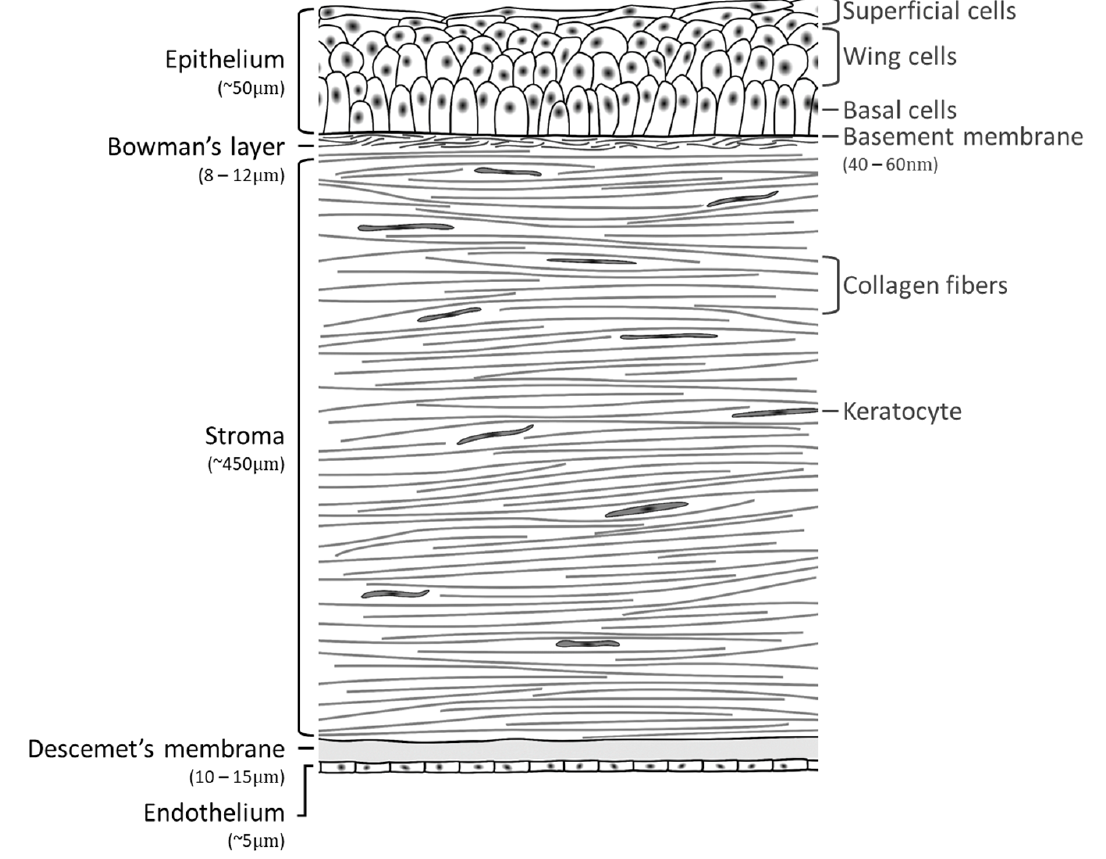
Figure 1. Representation of the human cornea cross-section. Reproduced from [7].